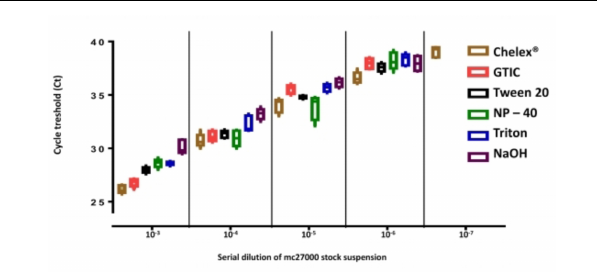
FIGURE 6 | Comparison of DNA extraction protocols in spiked sputum samples. The M. tuberculosis mc 2 7000 stock suspension was diluted and used to spike negative sputum samples. Box plots with C T median, 10th, 25th, 75th, and 90th centiles of 10 replicates. Methods are indicated by colors: brown: Chelex R (cid:13) method; pink: Guanidium Isothicyanate/ Tris-HCl/EDTA + 3 cycles of freeze thawing and boiling; black: Tween 20/Tris-HCl/EDTA/lysozyme+proteinase K/SDS + warming cycles 56 ◦ C/95 ◦ C; green: Nonidet P-40/Tris-HCl/EDTA/lysozyme+proteinase K/SDS + warming